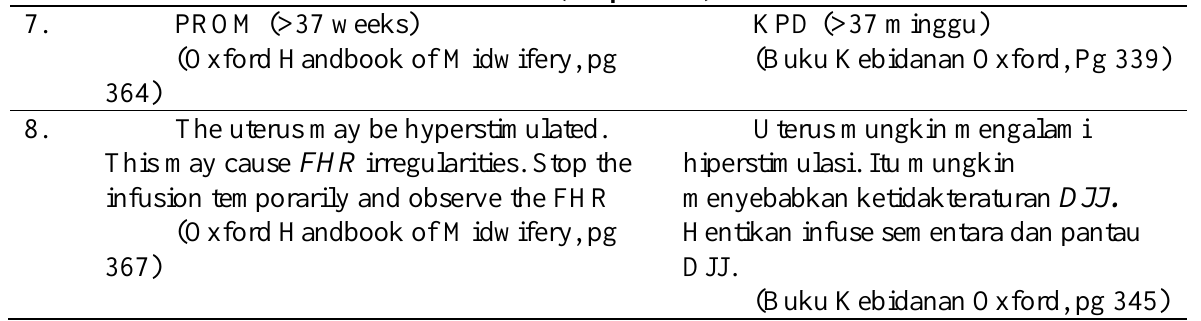
Abbreviation translated into abbreviation